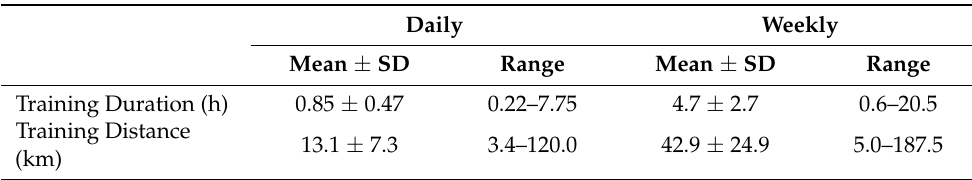
Table 4. Training volume of recreational endurance runners ( n = 2455).